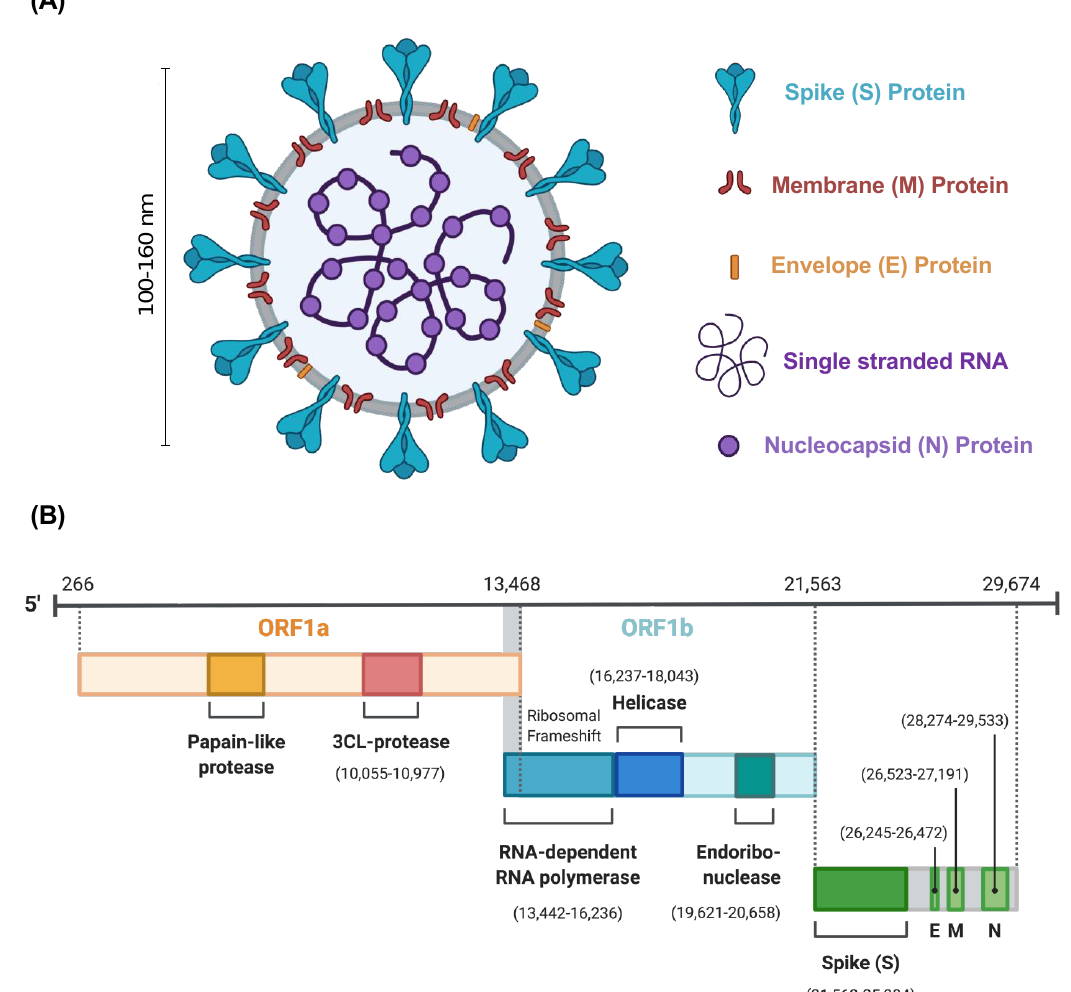
Figure 1. SARS-CoV-2 virus structure and genome. ( A ) Structure of SARS-CoV-2 virus including membrane (M), spike (S), envelope (E), and nucleocapsid (N) proteins, and single stranded RNA. The size of the virus is reported to be 100 – 160 nm. ( B ) The genomic structure of SARS-CoV-2 depicting open reading frames (ORF1a and 1b) with nonstructural proteins like 3CL protease, RNA dependent RNA polymerase (RdRp), helicase, endoribonuclease, and four structural proteins (S, M, E and N).